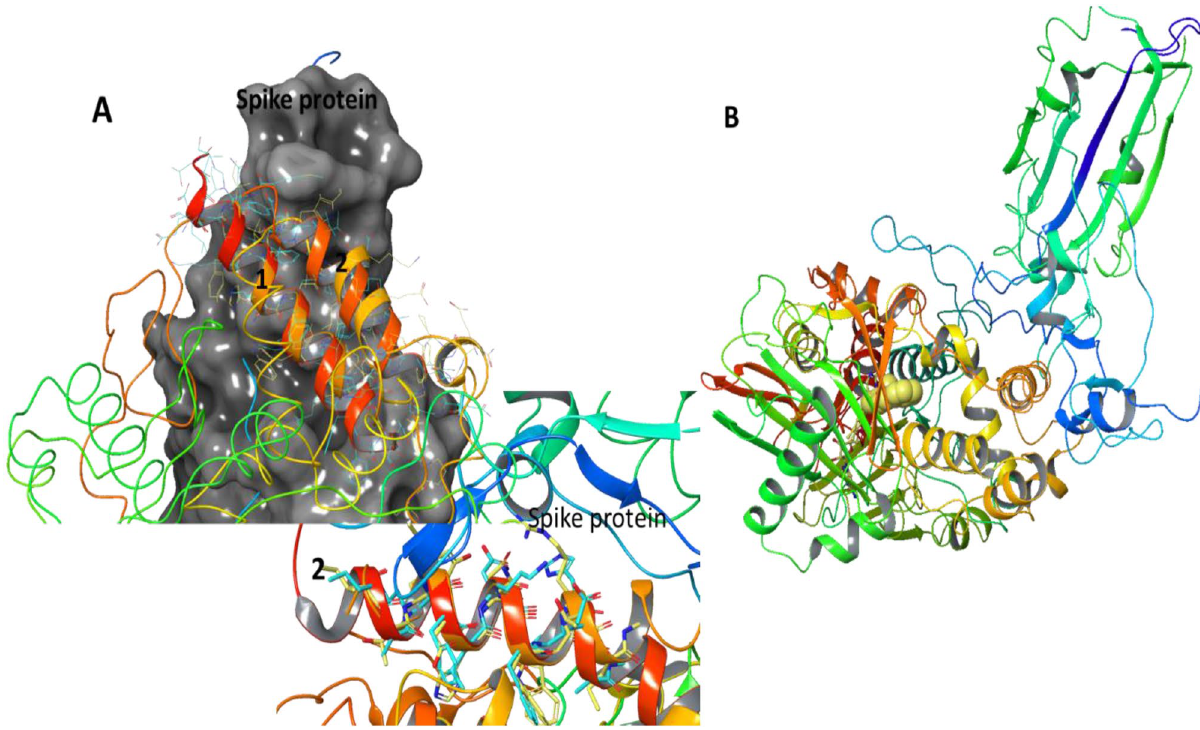
Figure 6. ( A ) Analysis of the overall structure similarity between ACE2 and MAOB using jFATCAT_flexible 33 resulting in 6M0J Similarity: 42% 1GOS Similarity: 51% P-value: 6.67e−01. Further analysis of structure subsection structural alignment in the regions of ACE2 related to binding Spike protein are shown in 1 and 2 showing major similarity (section 1 6M0J Similarity: 100% 1GOS Similarity: 100% P-value: 1.67e−02 section 2 6M0J Similarity: 74%; 1GOS Similarity: 100% P-value: 5.01e−01); ( B ) Hypothetical binding between Spike protein and MAOB outlining the ligand location in the MAOB protein. Figure and analysis is done using Schrodinger 2020–2 (Schrodinger Inc.) 35